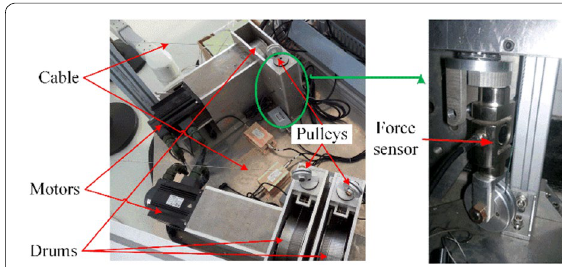
Figure 10 Drive unit and force sensor